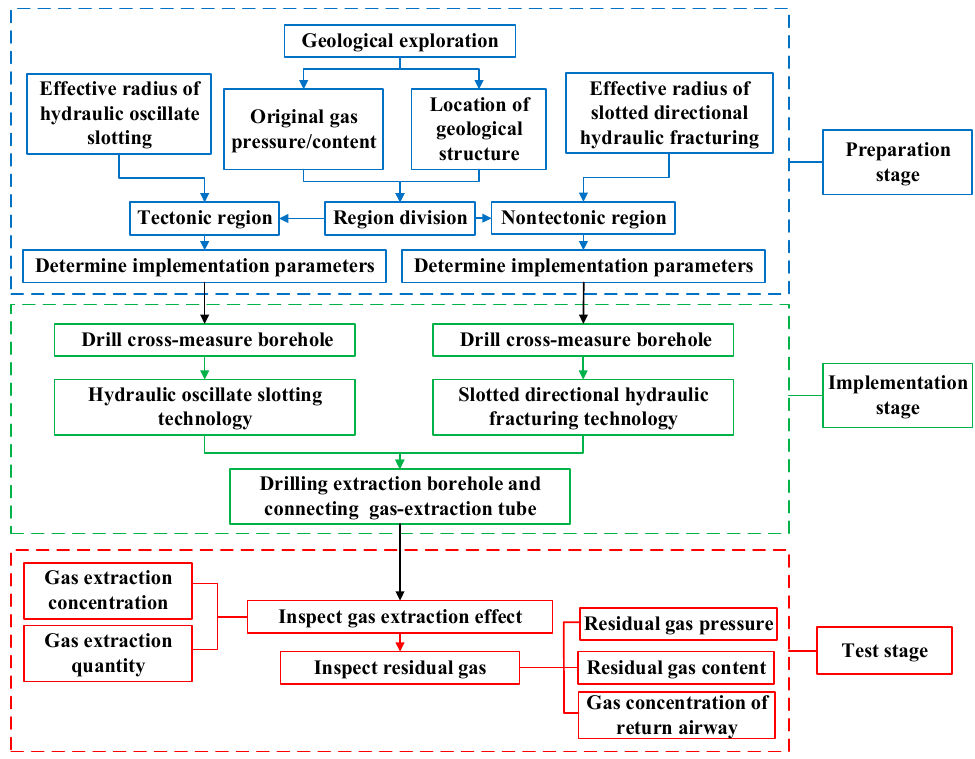
Figure 3. Technical process of the novel hydraulic technology mode.